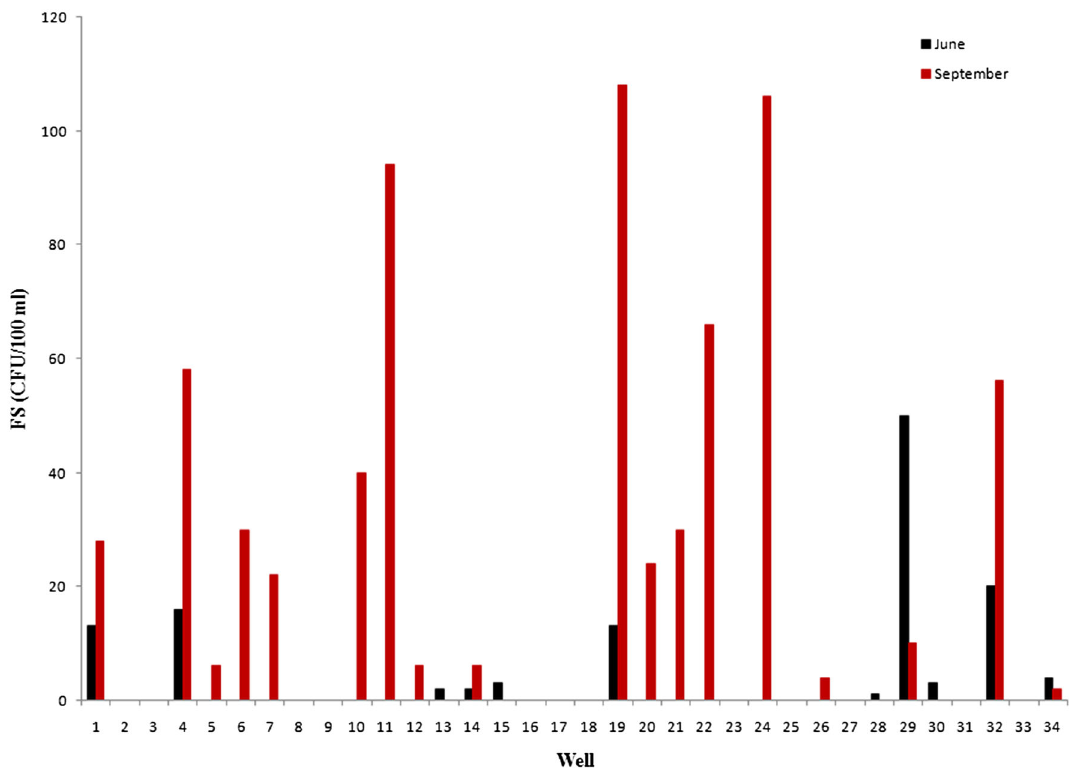
Fig. 4 Abundance of FS in groundwater ( vertical axis ) as sampled in June and November 2013 ( horizontal axis